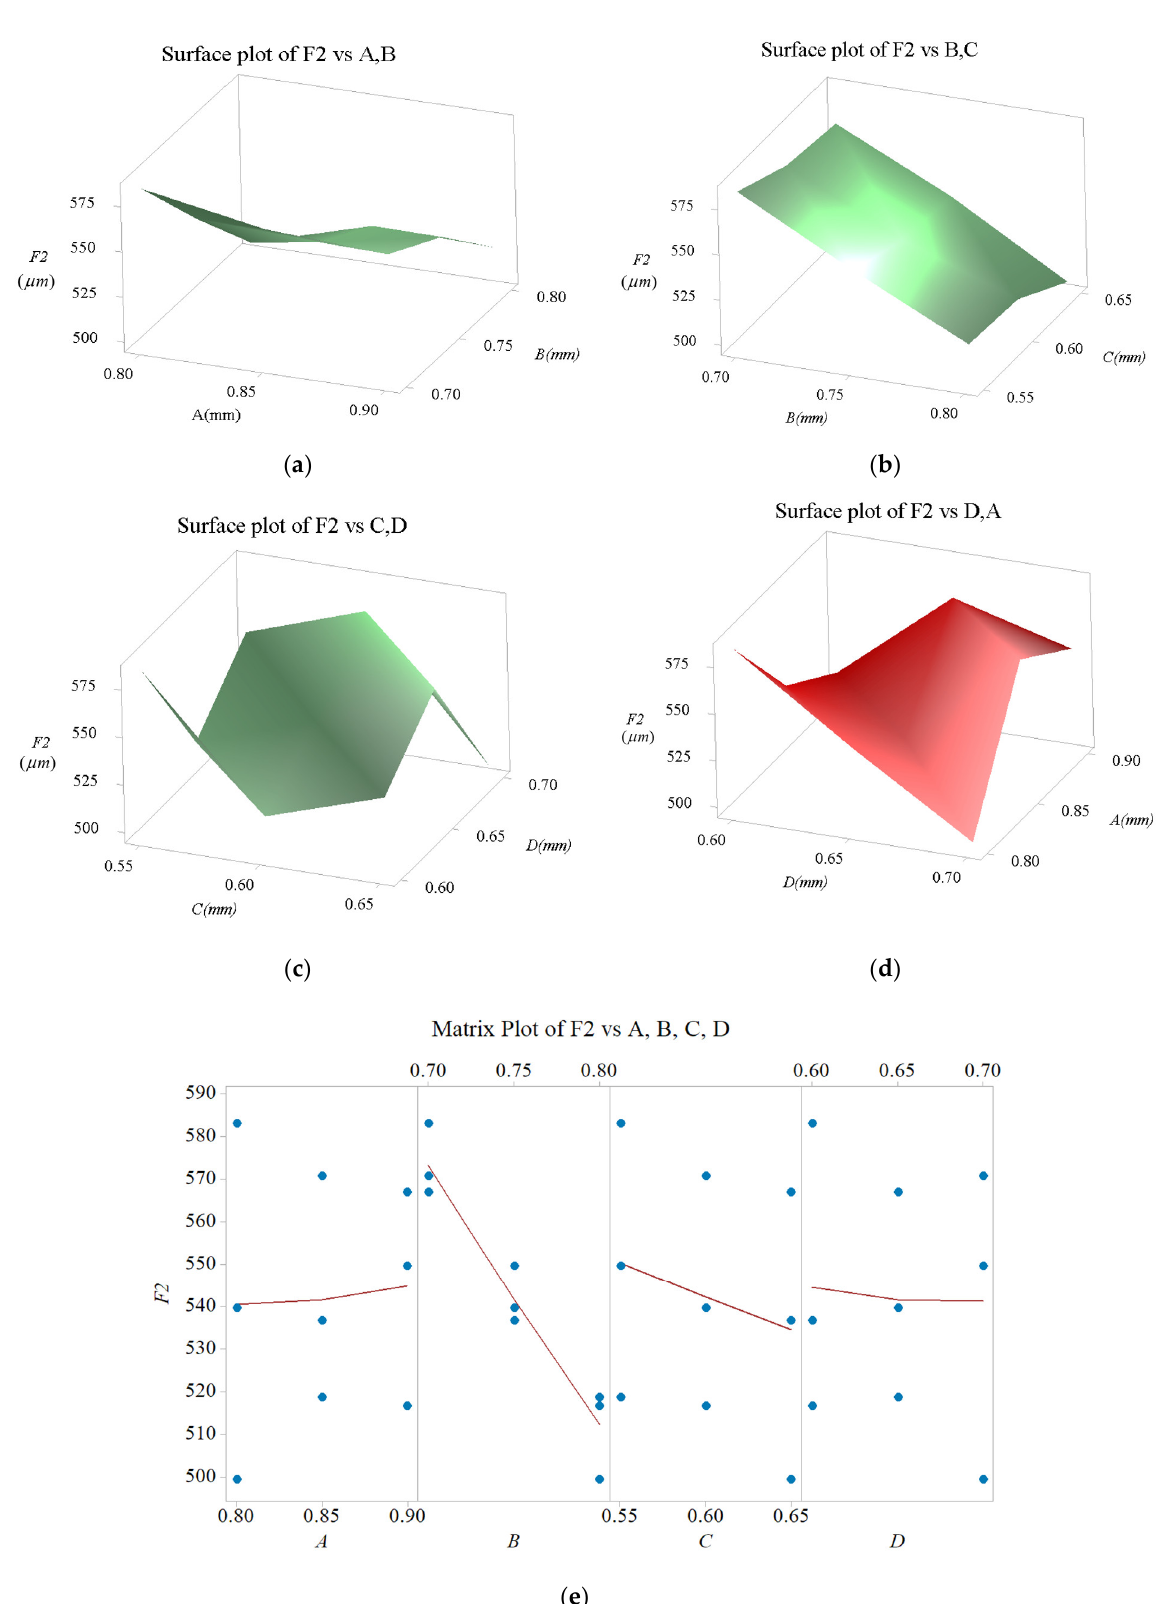
Figure 15. Influence diagram on output displacement: ( a ) of A and B, ( b ) of B and C, ( c ) of C and D, ( d ) of D and A, ( e ) of A, B, C and D.